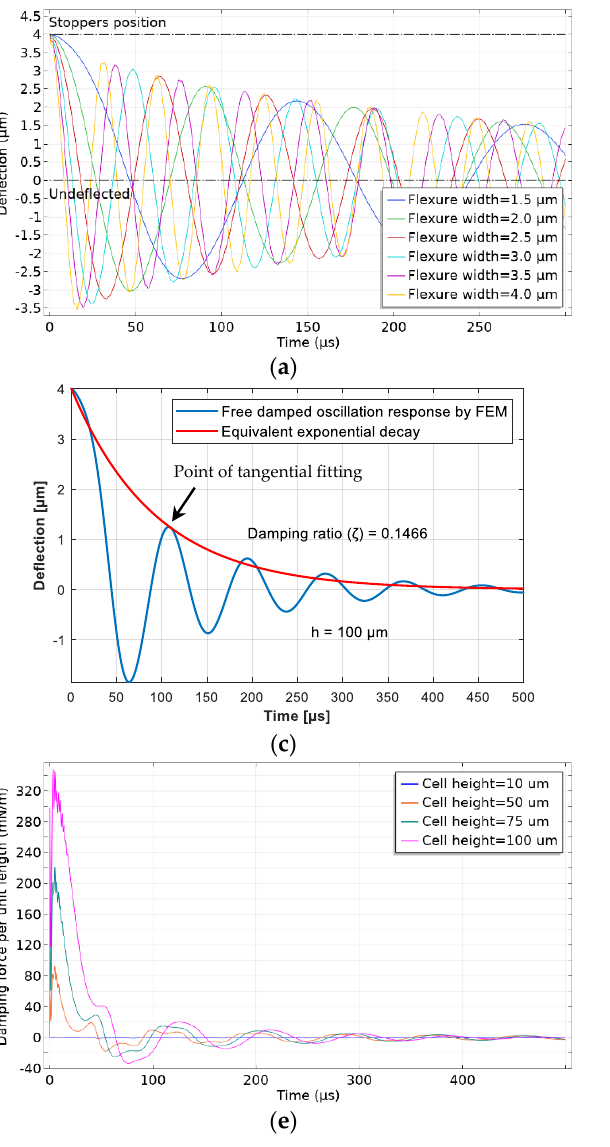
Figure 10. Transient parametric analyses of the pull-out time by the free damped oscillation response of the AUC after being released from the fully deflected position in a 2D FEM model corresponding to Table 1: ( a ) with flexures of various stiffnesses (via flexure width sweep, w x and w y ) and ( b ) with a sweep of the cell height h . ( c ) An example of the analysis carried out on the responses shown in ( b ) to extract an equivalent damping ratio by fitting an exponentially decaying envelop to the upper curvature of the response after a complete first oscillation. The plotted response belongs to the 100 µ m high structure. ( d ) The equivalent damping ratio due to SQFD as a function of the cell height. ( e ) The SQFD force per unit length of the thin-film exerted on the AUC with different cell heights. ( f ) An estimation of the pull-out time as a function of the cell height by applying a settling reference (a realignment margin δ) of ±1 µm to the response curves plotted in ( b ).